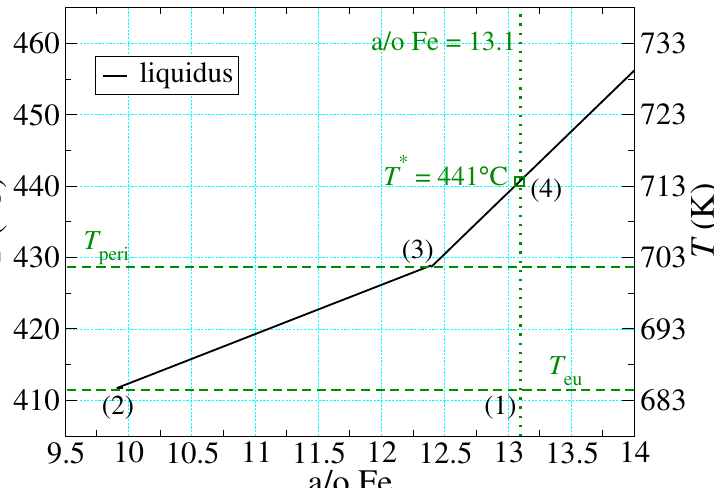
Figure 3. Enlarged view of the Pu 6 Fe phase diagram relevant to reanalysis of the DSC data shown in Figure 1. The liquidus curve is solid black, the eutectic and peritectic are dashed green, and the STR composition is dotted